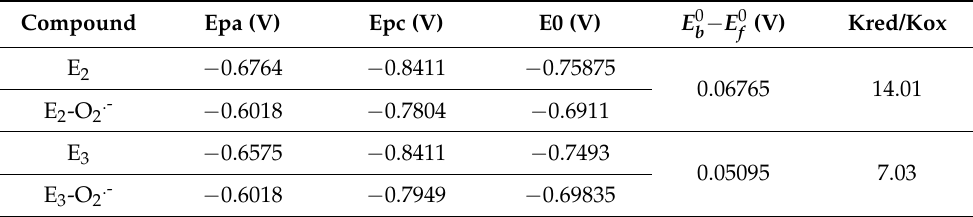
Table 9. Electrochemical data of free and O 2.- -bound forms of E 2 and E 3 used to calculate ratio of binding constants.